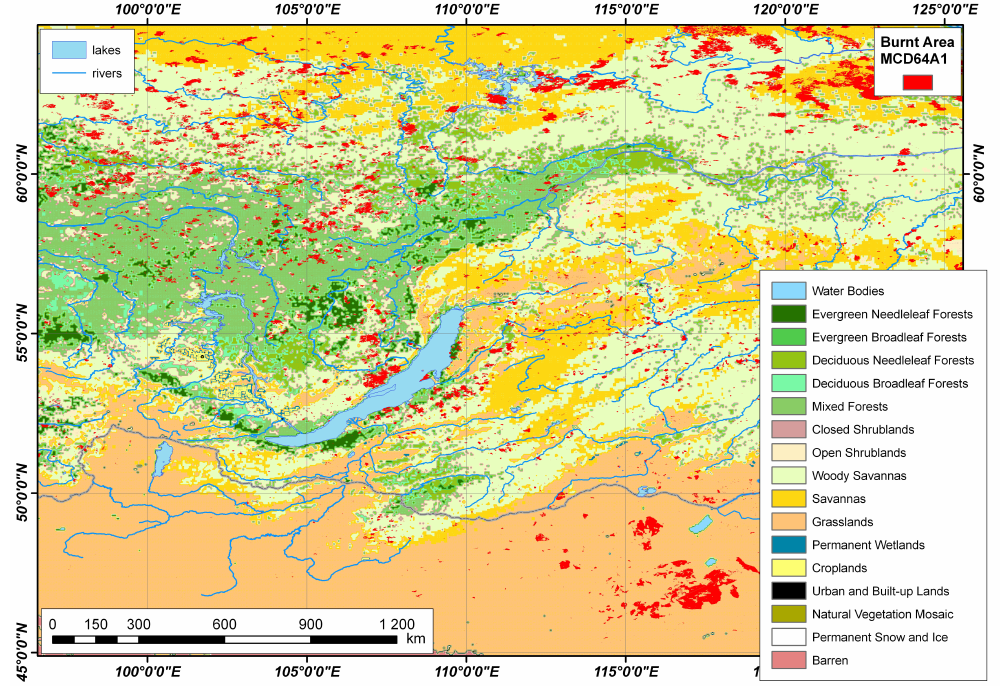
Figure 14. The total burned area, damaged by wildfires from June–August in 2010–2018, is shown. The burned area was obtained from the MCD64A1 (burned area, BA) dataset. The MCD12C1 land-cover map (2010) is presented as a